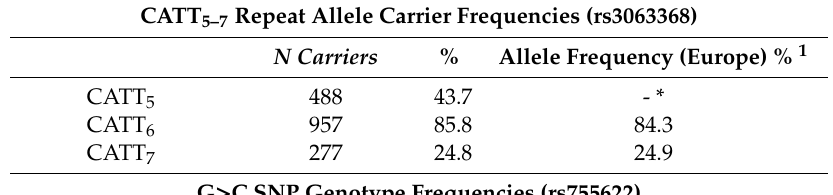
Table 2. Frequencies of the MIF CATT 5–7 repeat allele (rs3063368) and the G > C single-nucleotide polymorphism (rs755622) in 1116 patients undergoing cardiac